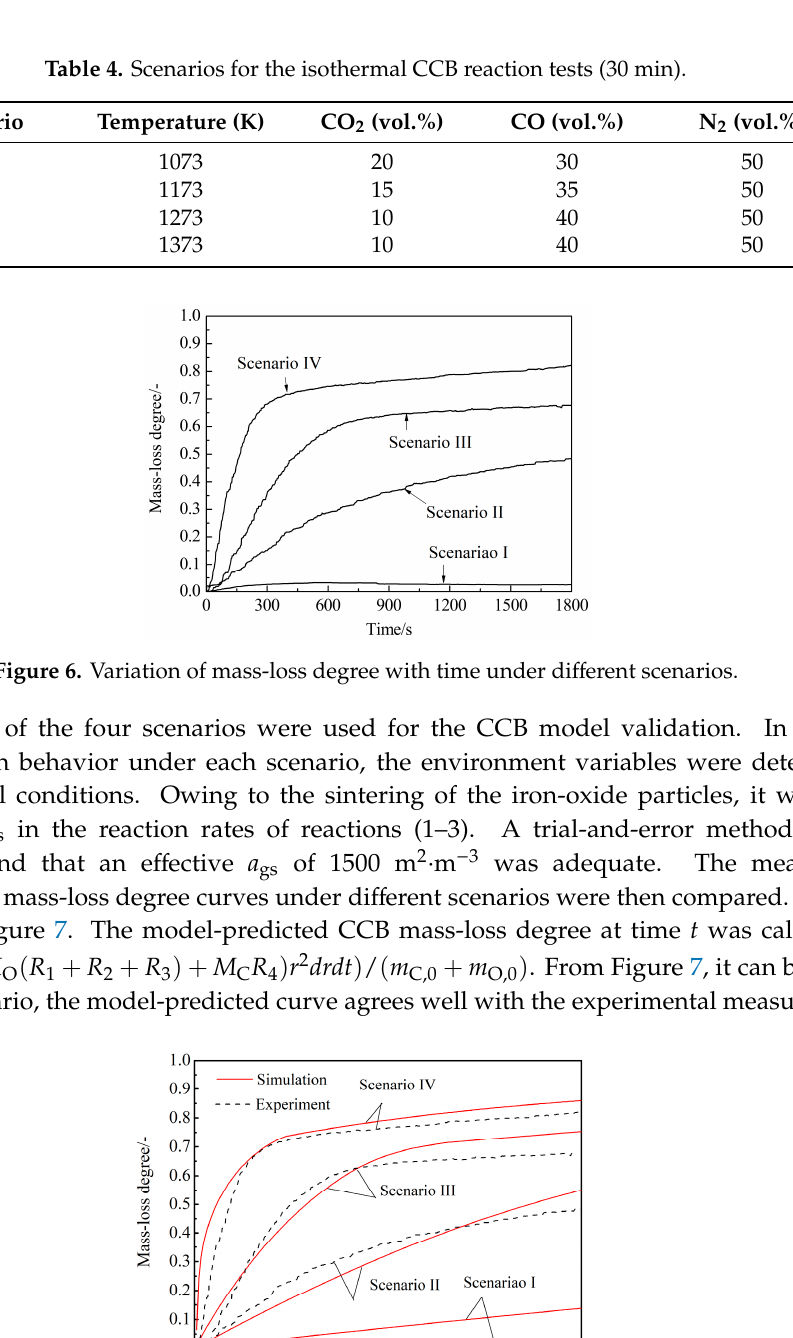
Table 3. CCB mineralogical composition (wt.%).